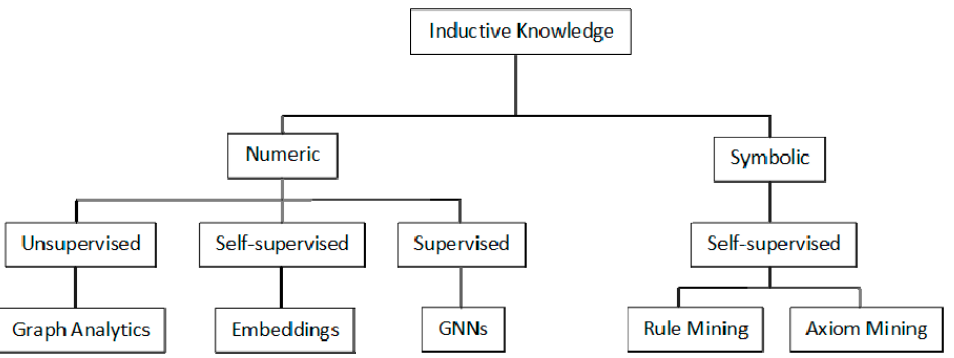
Figure 2. Conceptual overview of popular inductive techniques for knowledge.